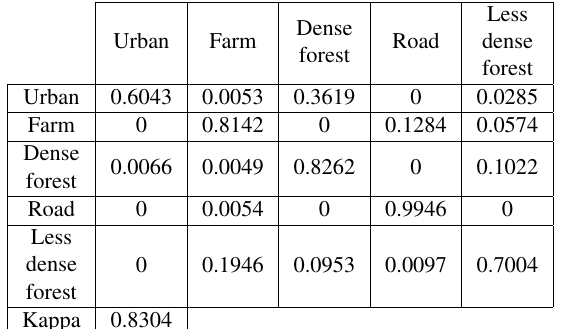
about 13 % . Confusion matrices in Table.1 and Table.2 shows that the total contribution of the new combination is over 5 %.